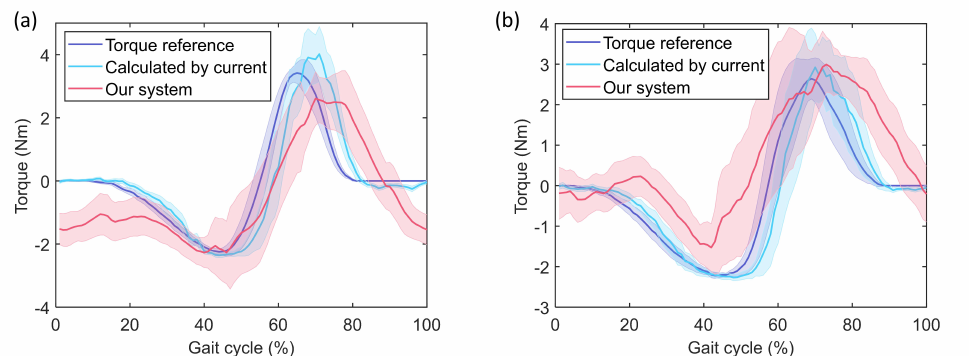
Figure 15. Results of hip exoskeleton test experiments. Experimental settings: ( a ) µ 1 = 0.45, µ 2 = 0.65, σ 1 = 12, σ 2 = 6; ( b ) µ 1 = 0.45, µ 2 = 0.65, σ 1 = 15, σ 2 = 10. The shadowed areas in the figure represent ± one standard deviations.